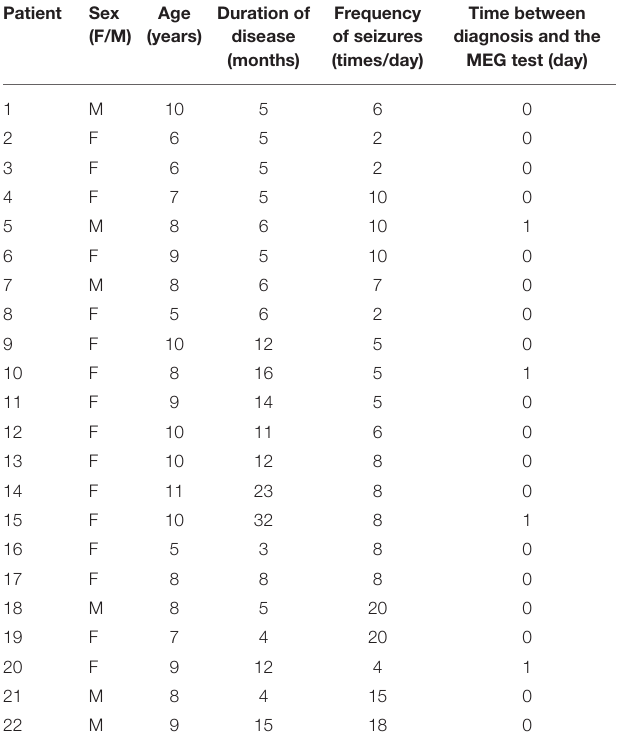
TABLE 1 | Characteristics of the patients with CAE. Patient